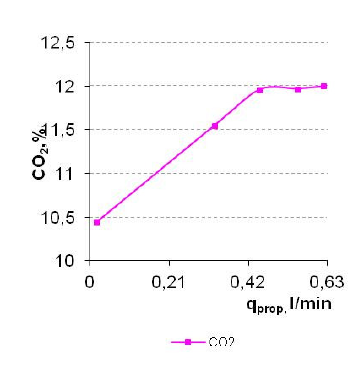
Figure 3. Effect of the propane supply on average values of the flame temperature (a).